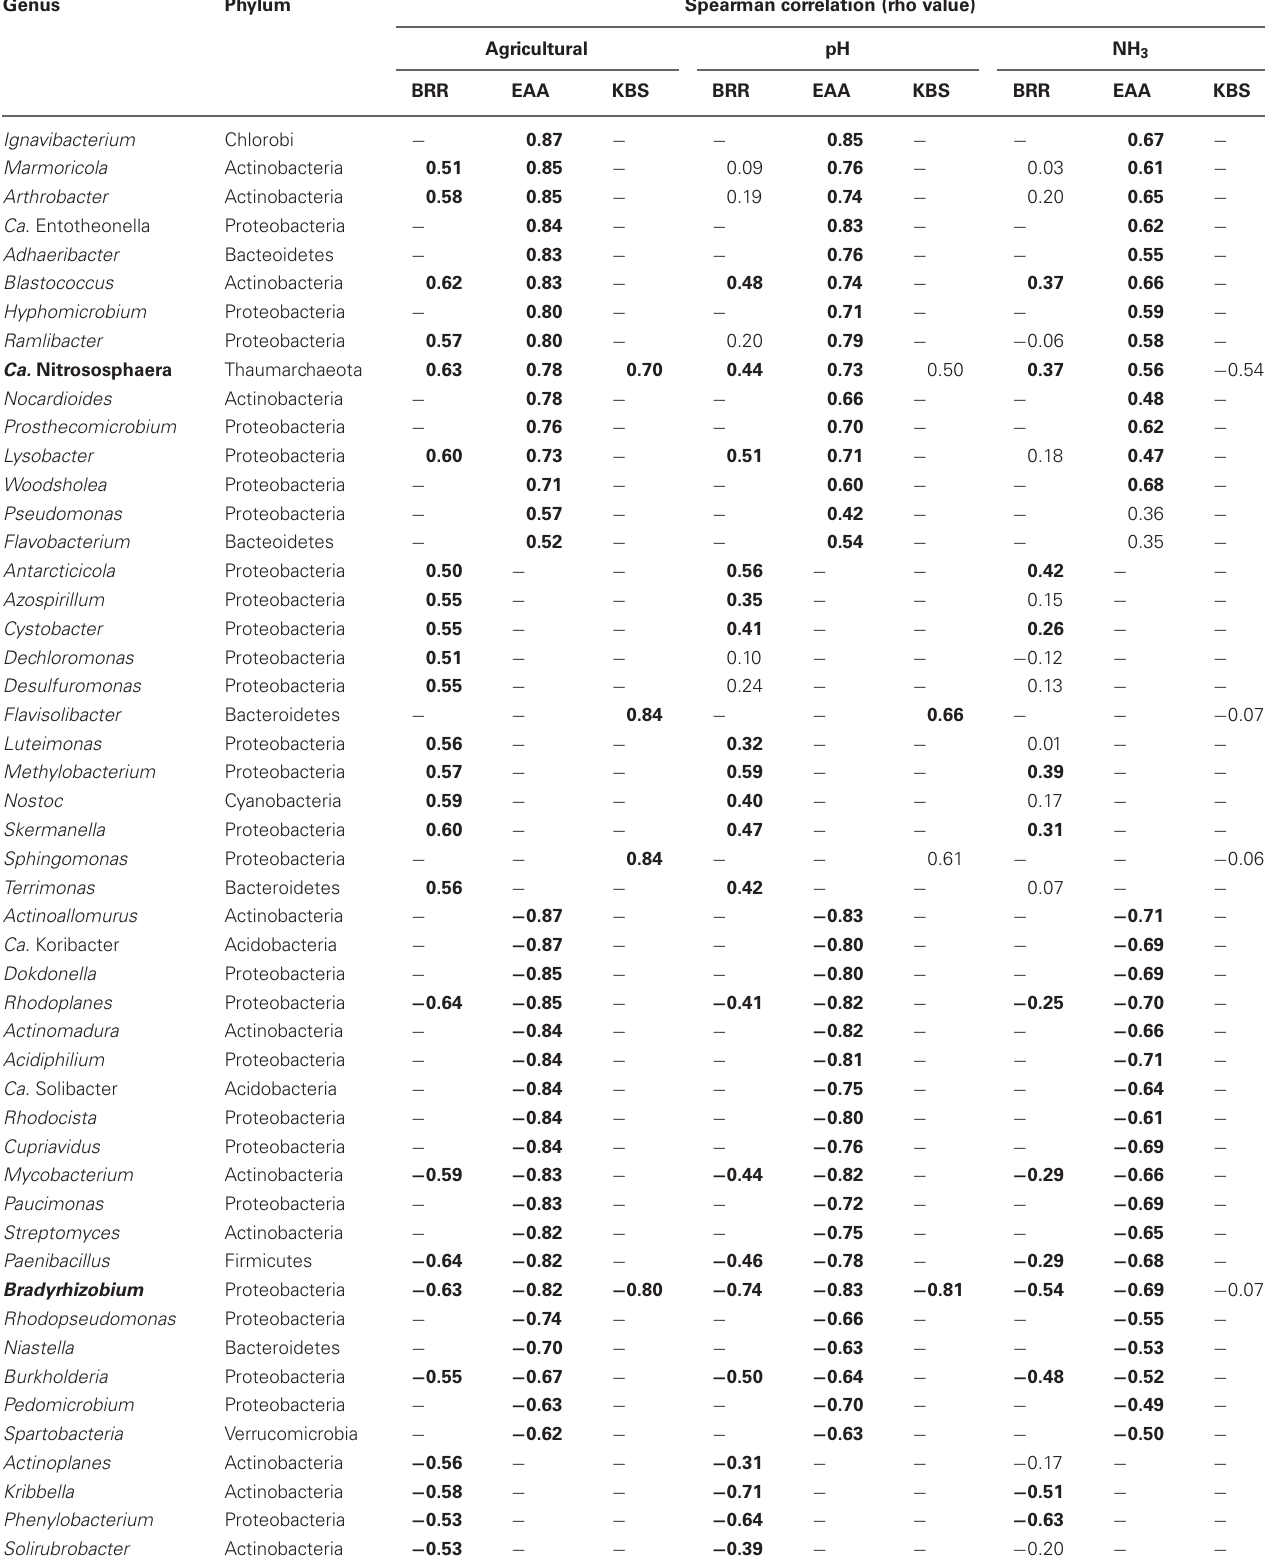
Table 3 | Genera highly correlated with agriculture in bold (16S rRNA ≥ 0.05%, rho ≥ ± 0.5, p ≤ 0 .